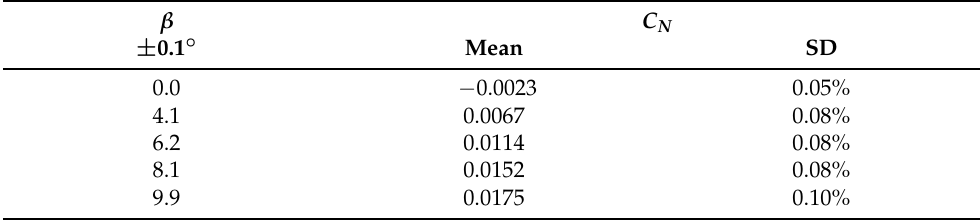
Table 3. Uncertainty in measurements of yawing moment coefficient. WBHVC configuration.